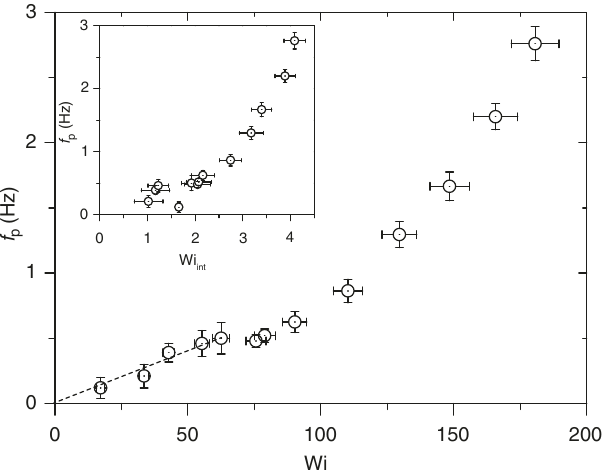
Fig. 4 Dependence of oscillation peak frequency on Wi. Dashed line is a linear fi t to the data in the regime above the elastic instability. Inset: f p as a function of Wi int . The error bars on f p are estimated from the spectral width of the oscillatory peaks of S f ( v ), and for Wi int they are calculated based on the s.d. from the mean value of ( ∂ u / ∂ y )